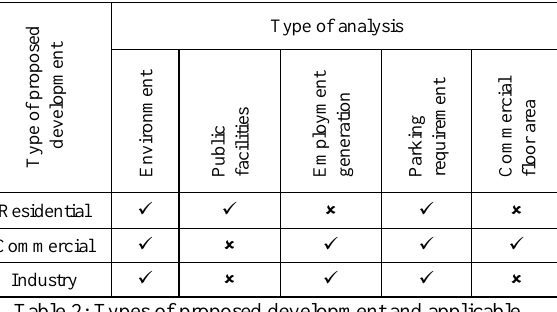
Table 2: Types of proposed development and applicable development impact